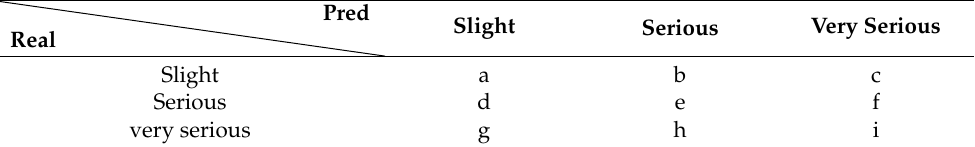
Table 3. Confusion matrix for the performance evaluation of traffic accident